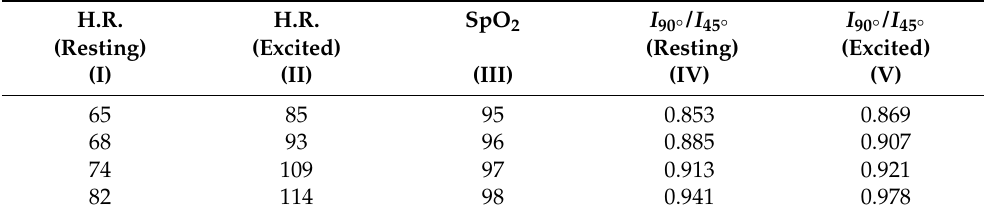
Figure 8. The variation in the I 90 ◦ / I 45 ◦ ratio for varying SpO 2 levels. Table 1. Measured heart rate and SpO 2 levels for the resting and excited states versus the I 90 ◦ / I 45 ◦ ratio obtained from the measurements. The heart rate and SpO 2 in columns I, II, and III are reference measurements from the commercial